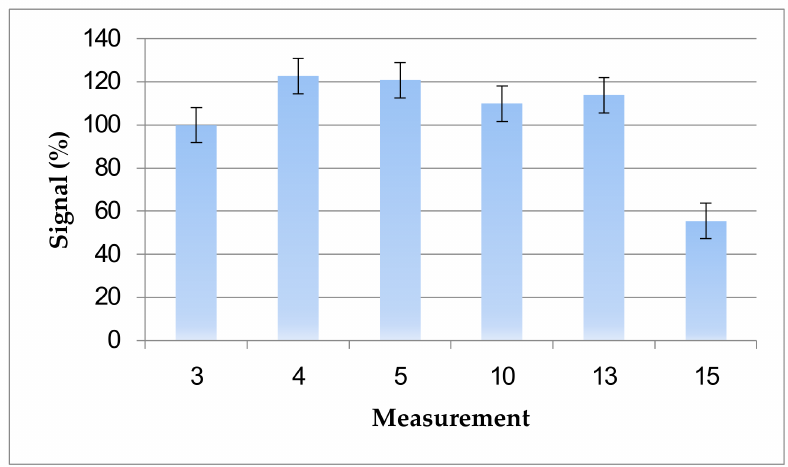
Figure 5. Reusability of the OTA-immobilized sensor surface after regeneration by 50 mM NaOH and 1% SDS. Measurements were made by application of 10F4 antibody to sensor surface. Error bars represent standard error. Each experiment was repeated three